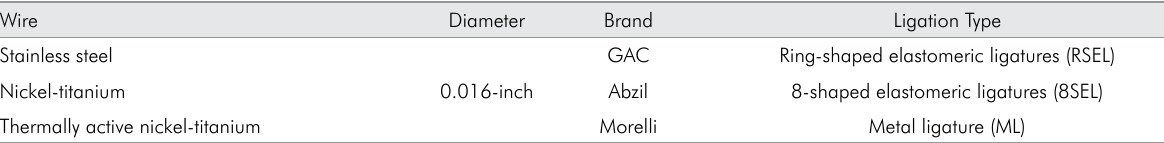
Table 1. Materials tested in this study